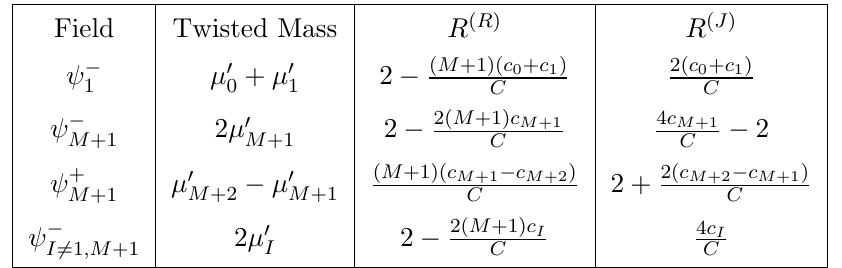
Table 5 . The spectrum of the charged sector around the (cid:12)rst vacuum k a = (cid:14) a;M +1 of equa- tion